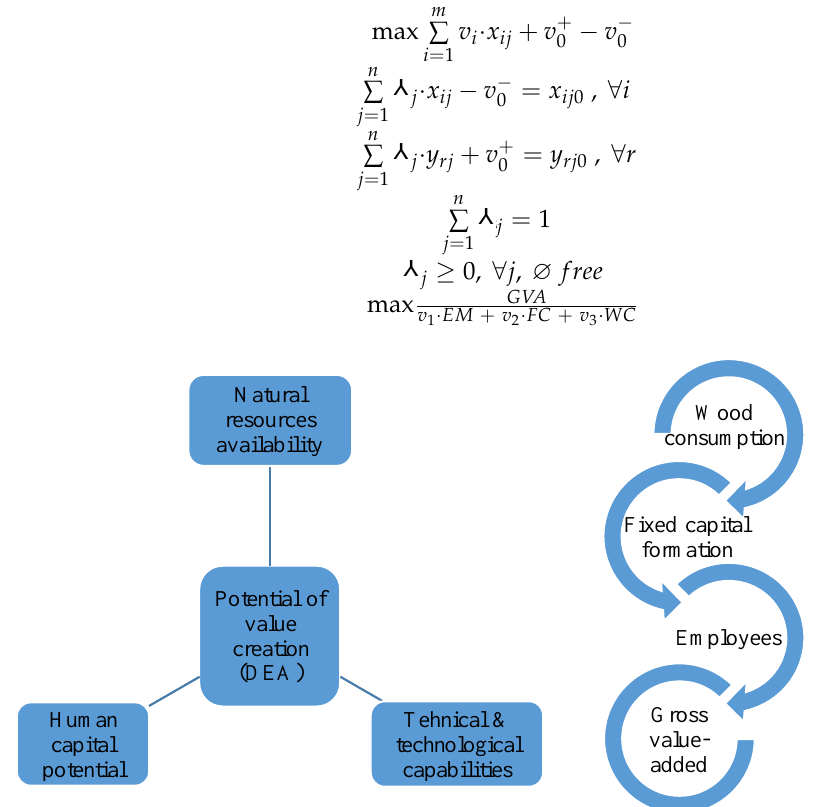
Figure 1. Diagram of the operationalization of potential value creation. Source: authors’ projection.